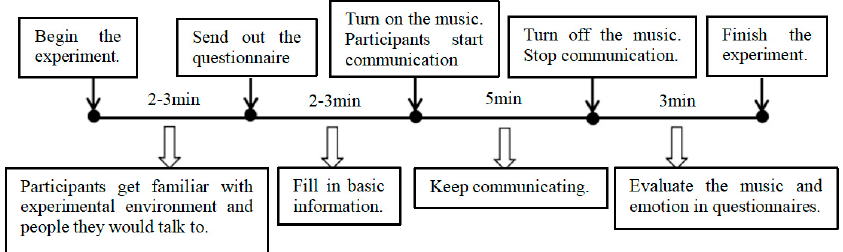
Figure 2. Experimental procedure showing the steps including familiarising experimental environment, listening to music to evaluating emotion.